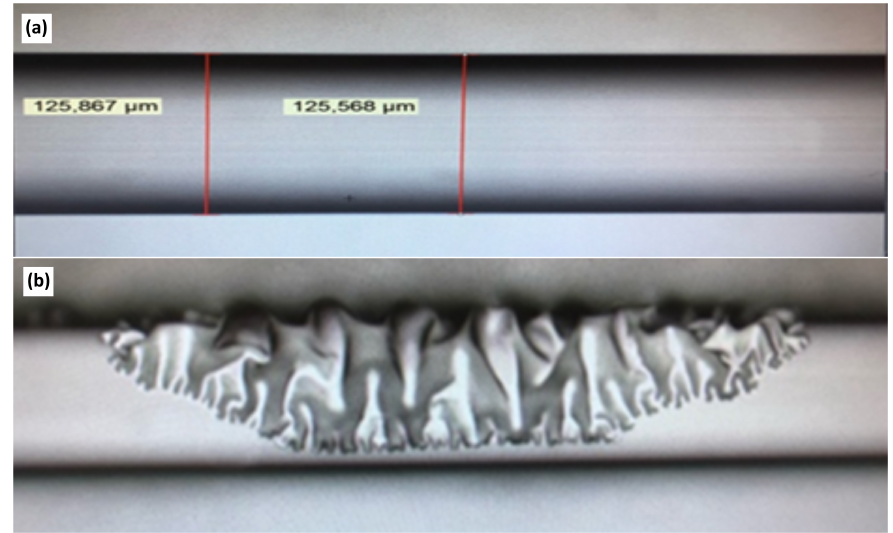
Figure 7. TCF coated with a thin, ∼ 0.5 µ m layer of pH-sensitive coating based on 1.3-BDDA and PIP ( a ). Large volume expansion of the polymer creating problem with adhesion to the glass fiber when the coated fiber is submerged in a liquid ( b